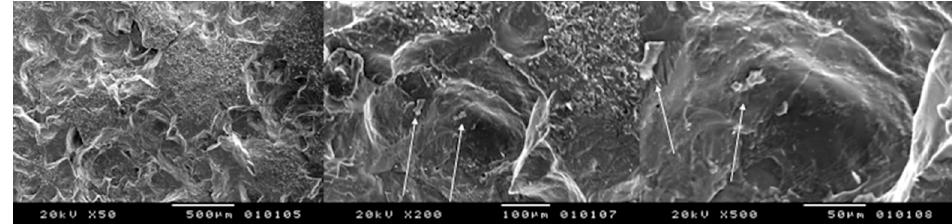
Figure 4. Peak power of 10 kW, speed of 50 mm/s: some points with melting are shown ( left ) X100; ( centre ) X200; ( right ) X500.